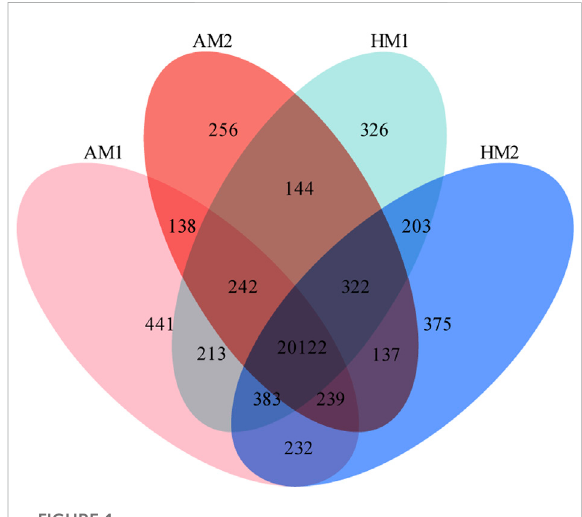
FIGURE 1 Venn diagrams of annotated genes in muscle tissue of Altay and Hu lambs exposed to different air temperatures. AM1: Altay lambs at − 5 ° C; AM2: Altay lambs at 20 ° C; HM1: Hu lambs at − 5 ° C; HM2: Hu lambs at 20 ° C.